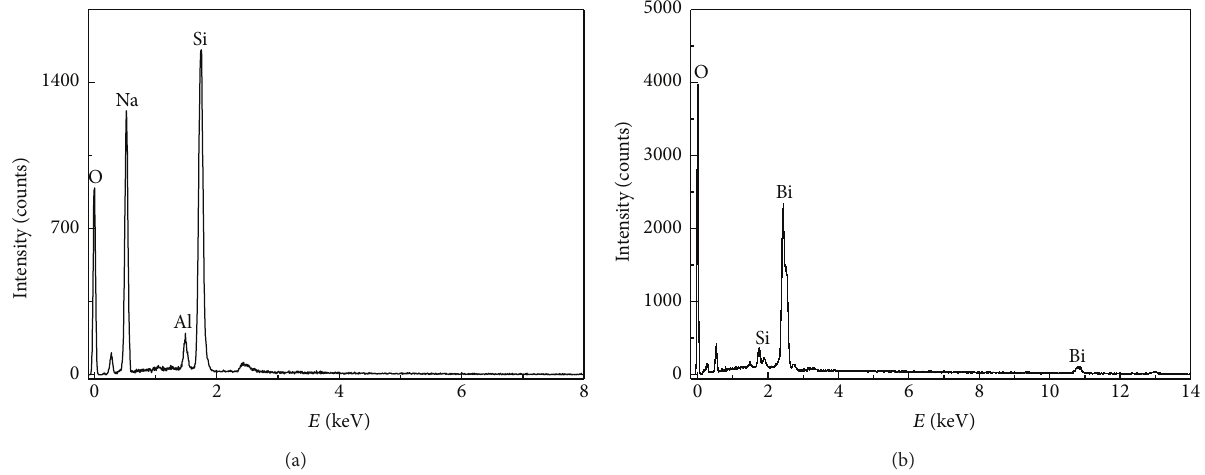
Figure 3: EDX spectra of quartz column: (a) before loading Bi 2 O 3 , (b) after loading Bi 2 O 3 .